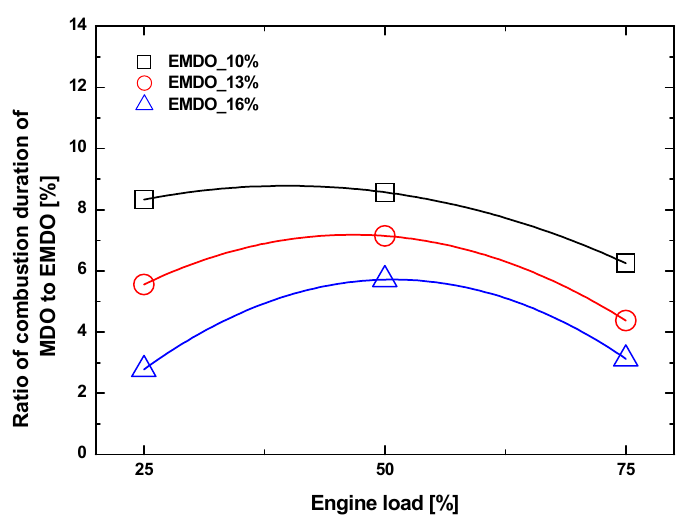
Figure 7. Ratio of combustion duration of MDO to EMDO according to BMEP and rpm.